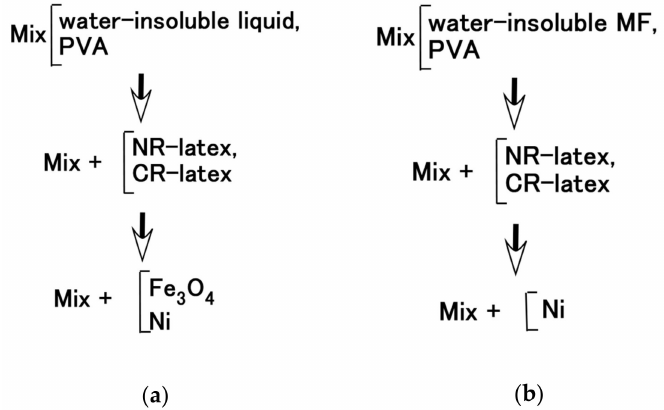
Figure 8. Mixing process for: ( a ) Figure 6; ( b ) Figure 7.